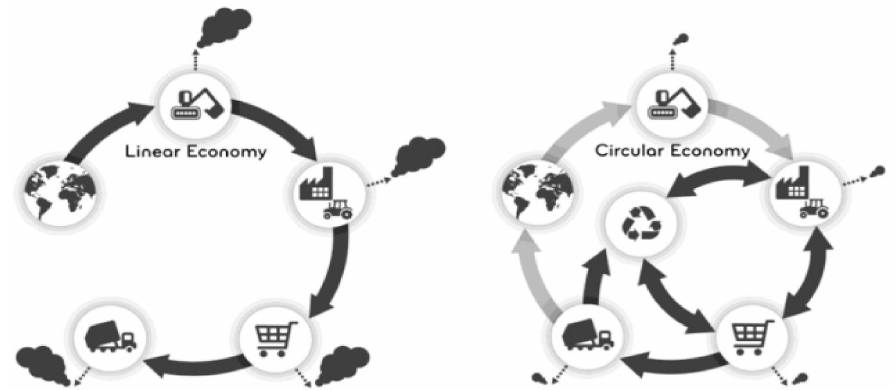
Figure 1. (L-R) Linear economy concept indicating an incomplete loop where the plant provides the extracted resources and receives the waste after the resources have been used. The Circular Economy concept keeps the product in use for as long as possible and is recycled at the end of its life. Adapted from Suave et al., (2015)